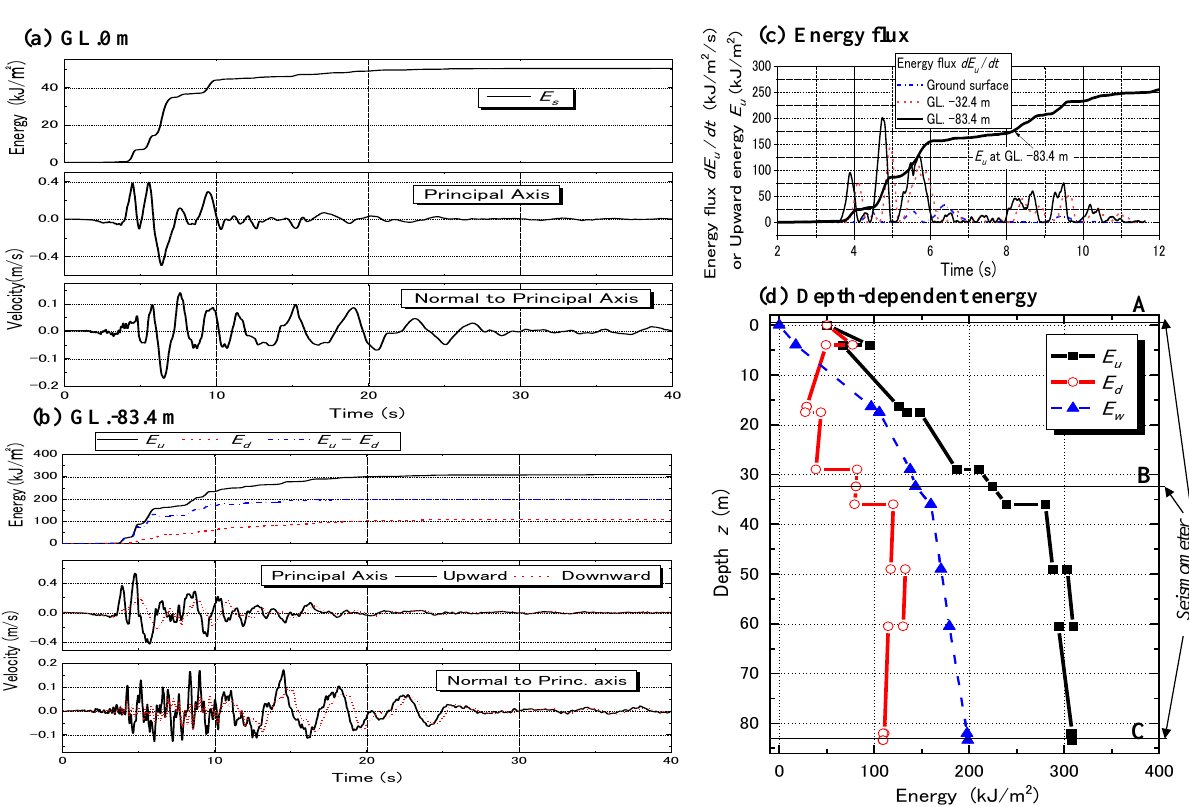
Figure 10. Calculation of wave energies in PI: time–histories of energy and particle velocity at GL. 0m ( a ) and at GL. −83.4 m ( b ), time–histories of depth-dependent energy flux ( c ), and depth-dependent cumulative energies E u , E d and E w ( d ).